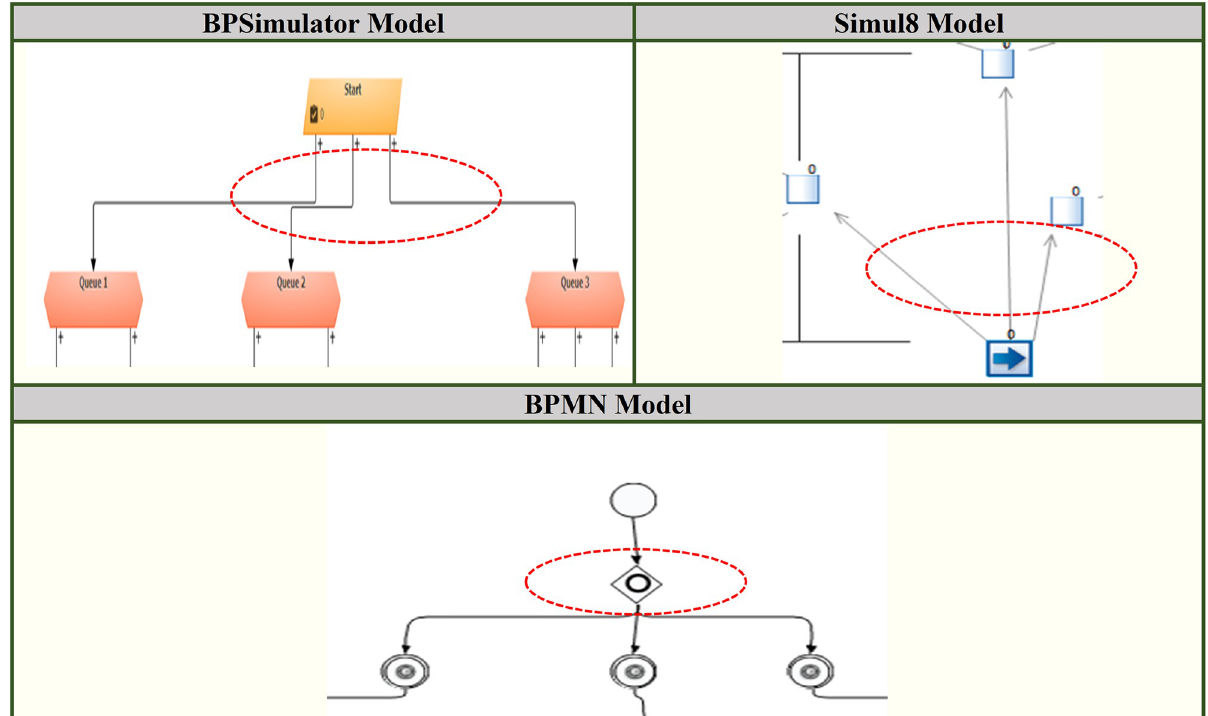
Fig 12. A part of bank model shown in dotted oval in BPSimulator and Simul8 is converted to parallel gateway in BPMN model.